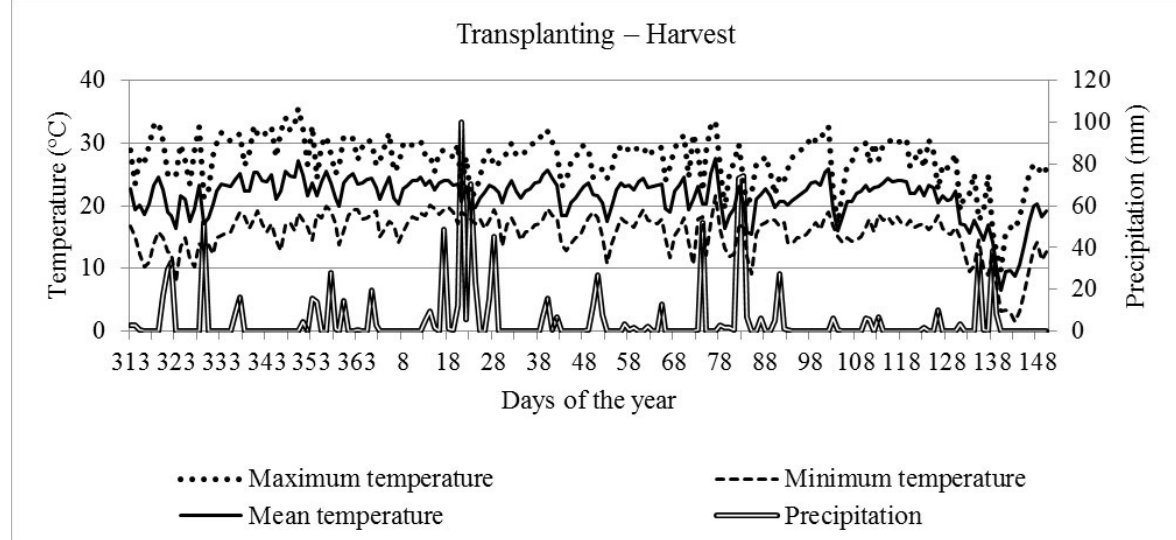
Figure 1. Minimum, mean, maximum temperatures and daily precipitation of seedling transplanting until the harvest of stems and